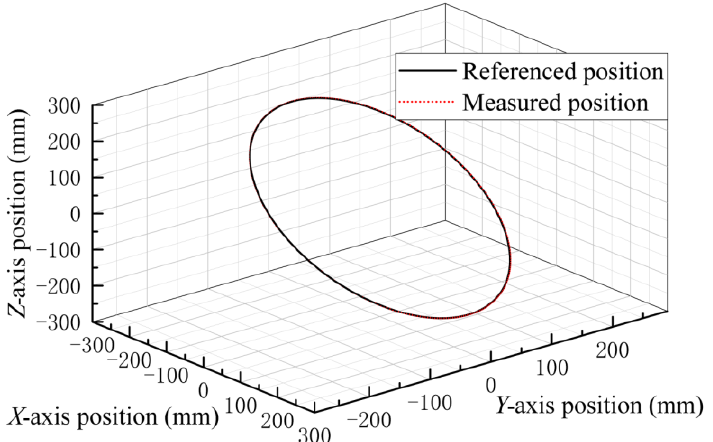
Figure 18. Circular-curve dynamic tracking of a three-axis translation table.